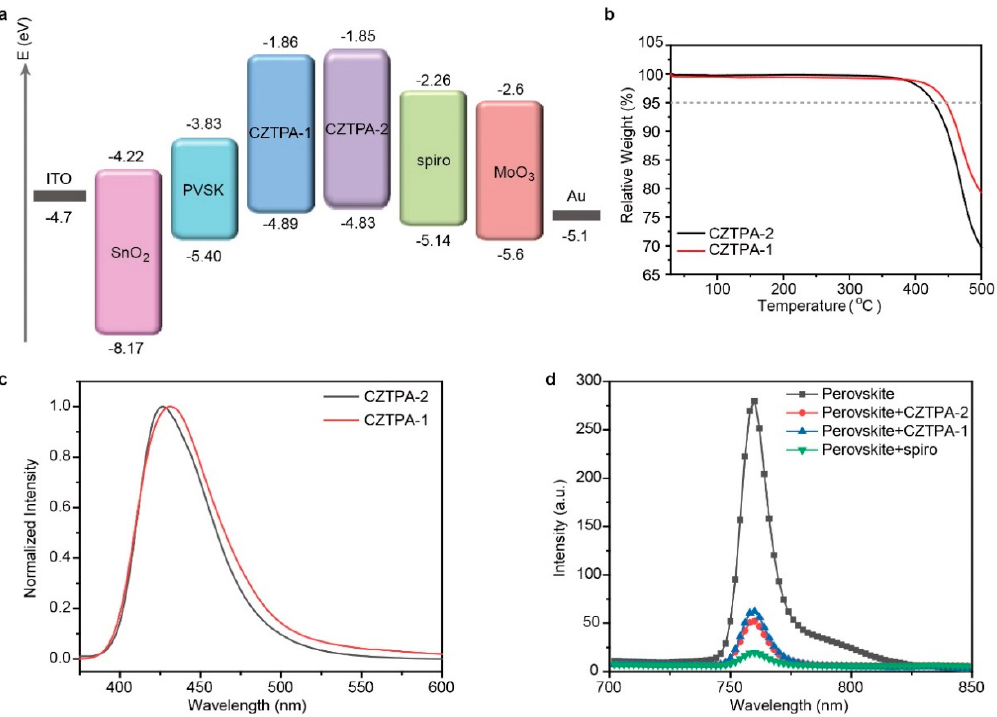
Figure 2. ( a ) Energy level diagram of a perovskite solar cell (PSC) with CZTPA-1, CZTPA-2, and 2,2 ′ ,7,7 ′ -Tetrakis[ N , N -di(4-methoxyphenyl)amino]-9,9 ′ -spirobifluorene (Spiro-OMeTAD). ( b )